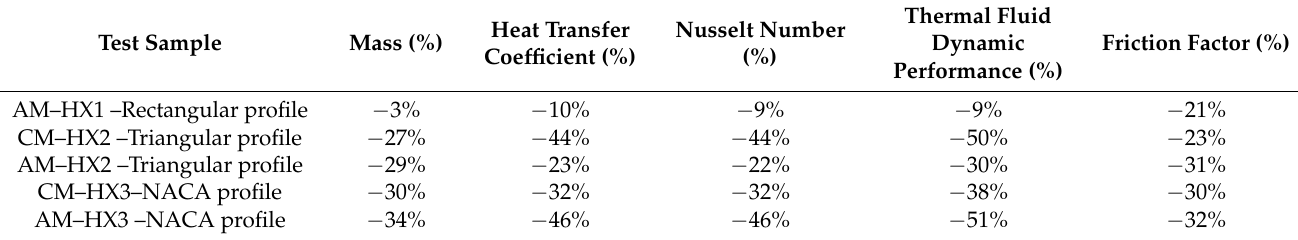
Table 3. Thermal performance of test samples compared to